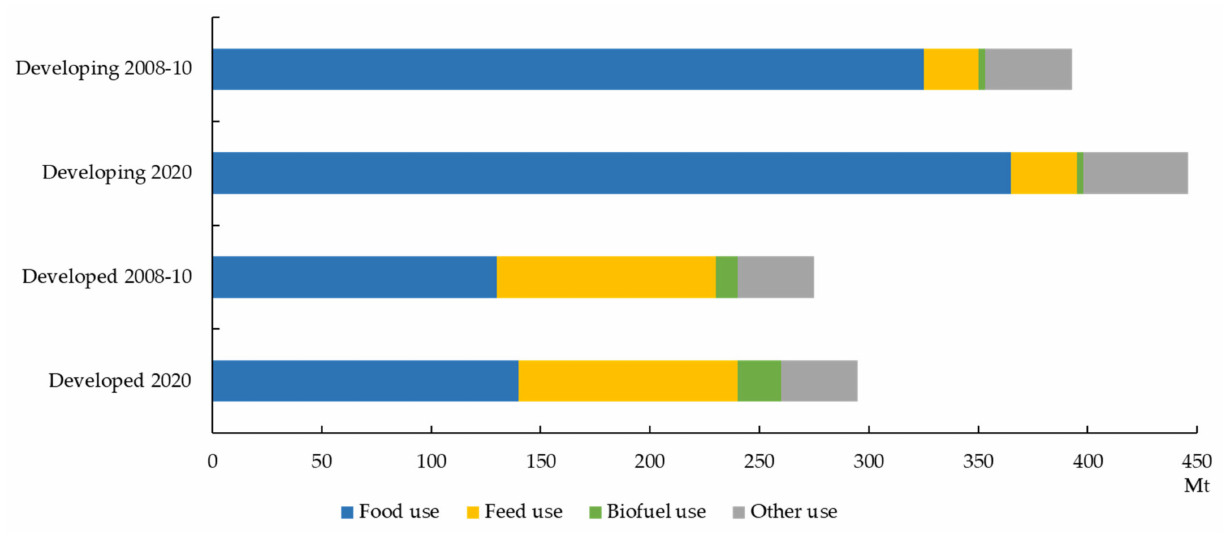
Figure 1. Wheat consumption in developed and developing countries. “Other use” refers to industrial uses of wheat. Source: OECD and FAO